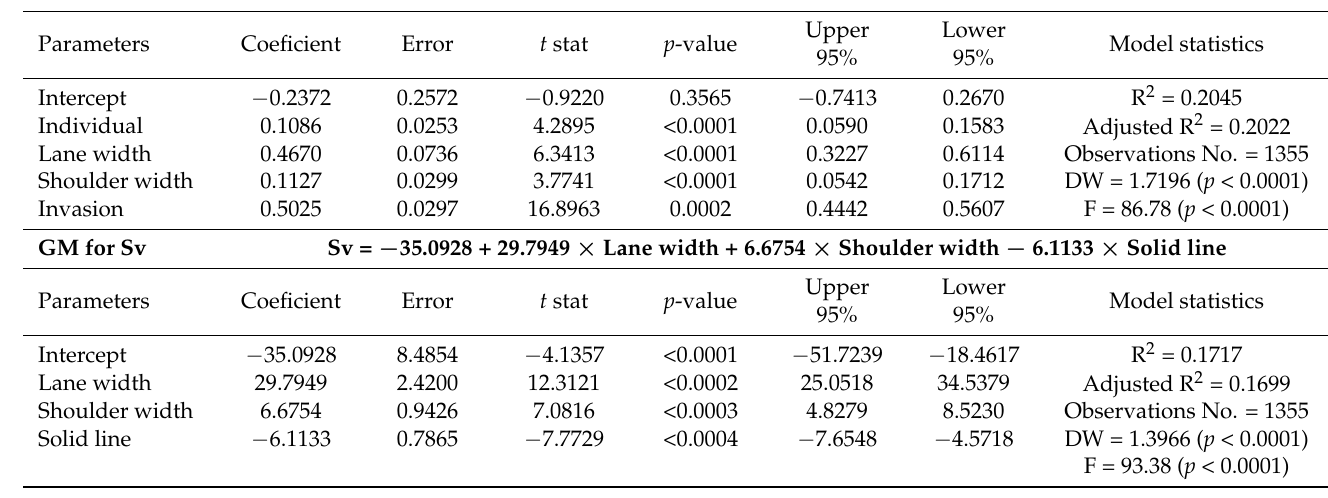
Table 3. General regression models for lateral clearance and overtaking vehicle speed considering cyclists riding individually or in